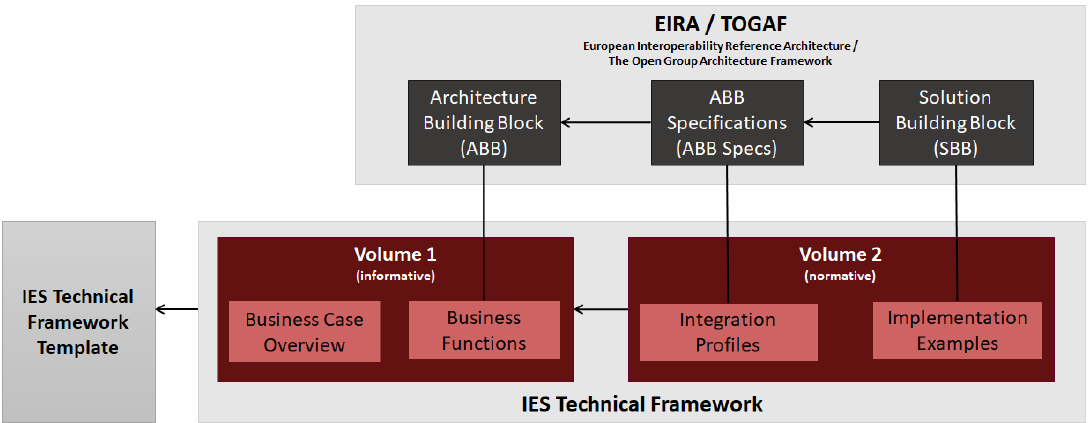
Figure 13. The Open Group Building Blocks: coarse relation of Business Function, Integration Profiles, etc. to Architecture and Solution Building Blocks used by